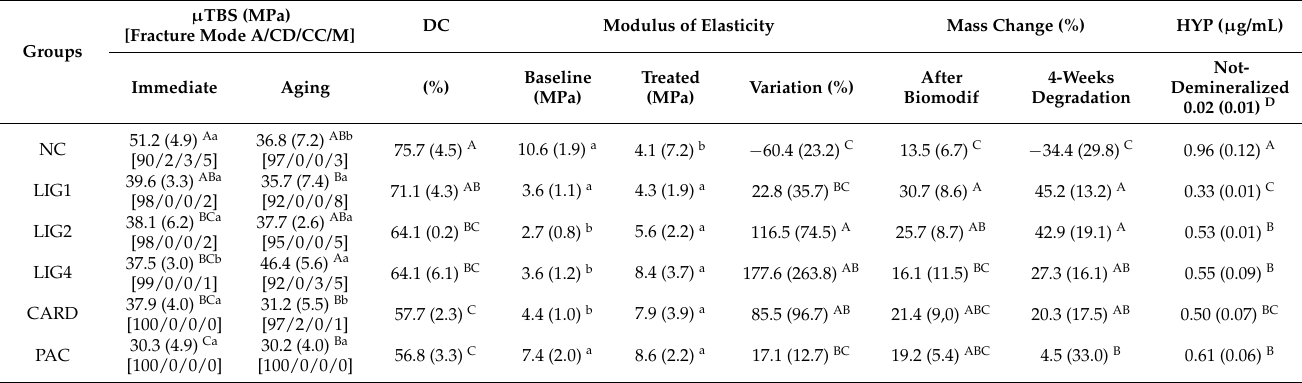
Table 1. Means (standard deviations) of quantitative results of various